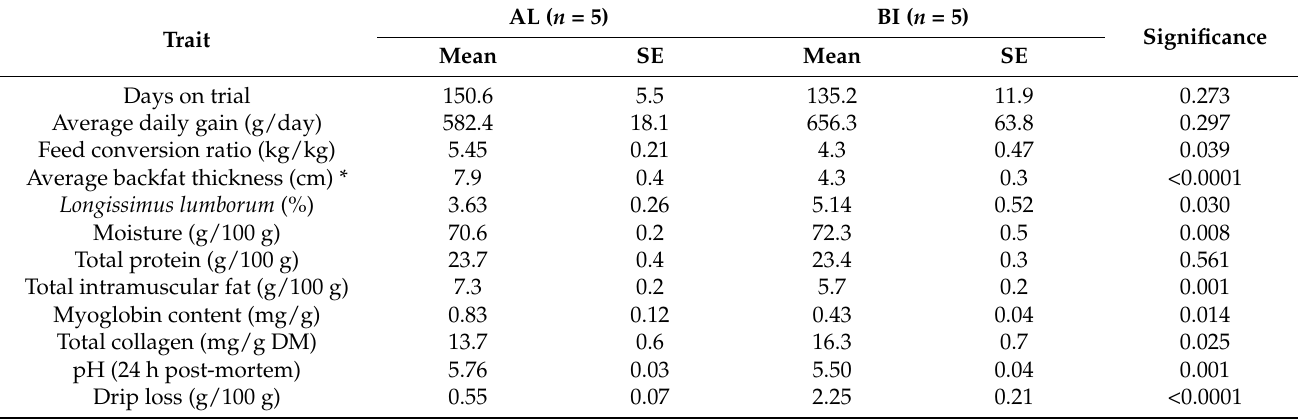
Table 1. Zootechnical traits and physical–chemical parameters from muscle Longissimus lumborum of Alentejano (AL) and B í saro (BI) pigs slaughtered at ~150 kg